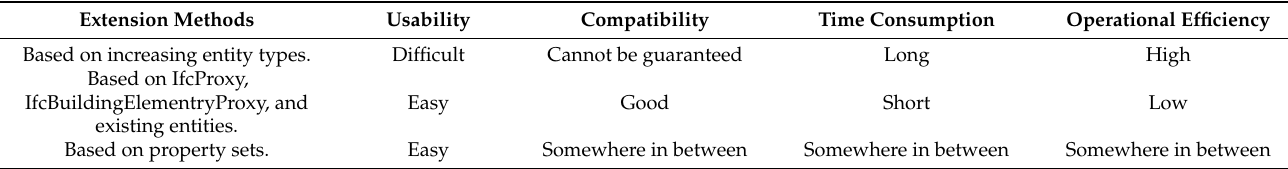
Table 2. Comparison of three extension